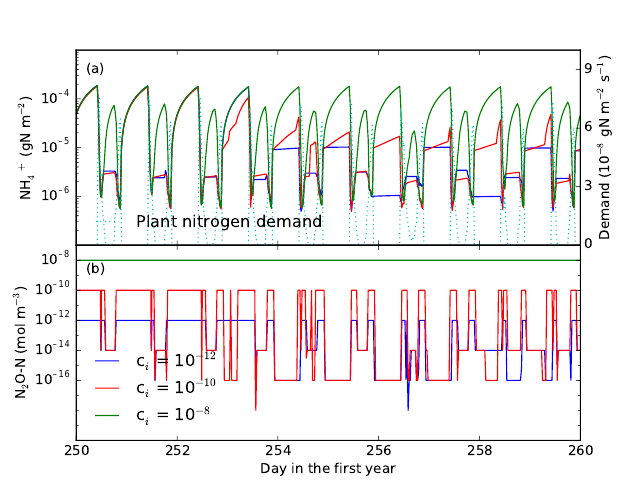
Figure 7. Resetting nitrous oxide concentration to 10 − 8 , 10 − 10 , and 10 − 12 molm − 3 in every CLM 0.5h time-step results in no inhibition to increasing inhibition of reactions when the scaling method is used with STOL = 10 − 8 . N 2 O − N concentration in the y axis in (b) is the minimum of the 10 soil layers. Numerical ex- periments are conducted for the tropical site for the first year with k m = 10 − 6 molm − 3 . See inset in Fig. 6e for ammonium concentra- tion in the first year with daily data points.